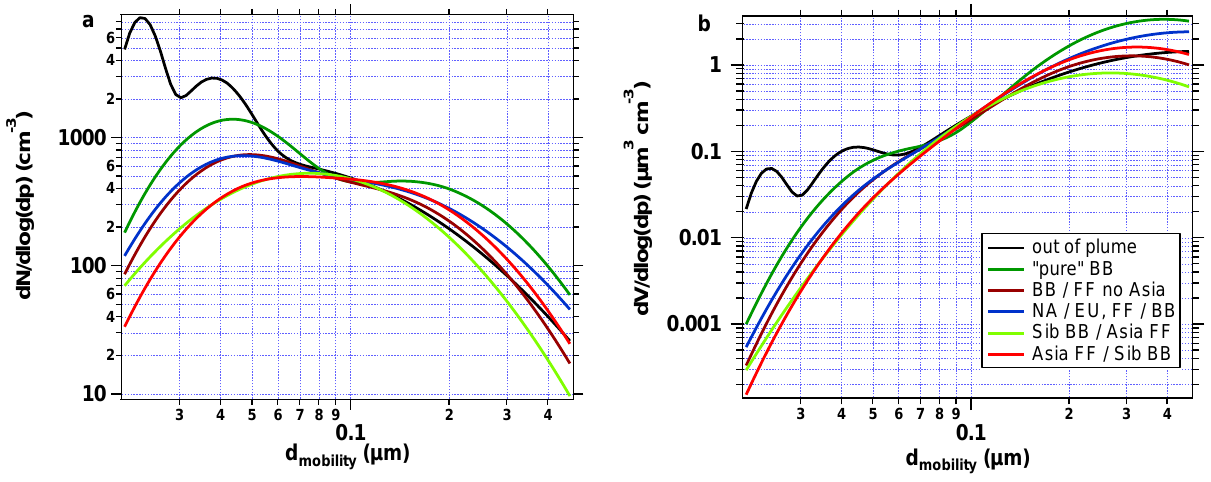
Fig. 13. Lognormal fits for SMPS number (a) and volume (b) size distributions for all five plume categories and all non-plume periods.